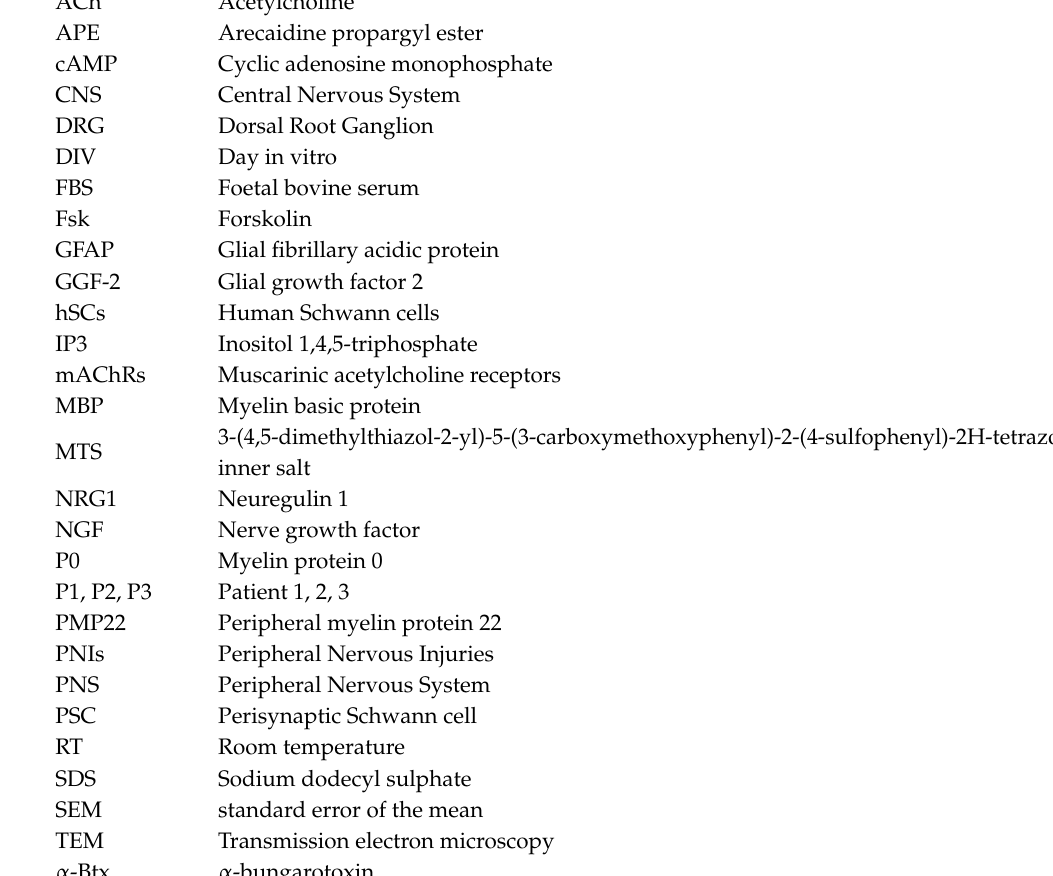
Figure S1. qRT-PCR analysis for muscarinic receptor subtypes. Table S1 . Statistical analysis of MTS assay after APE and muscarine treatment at the final concentration of 100 µ